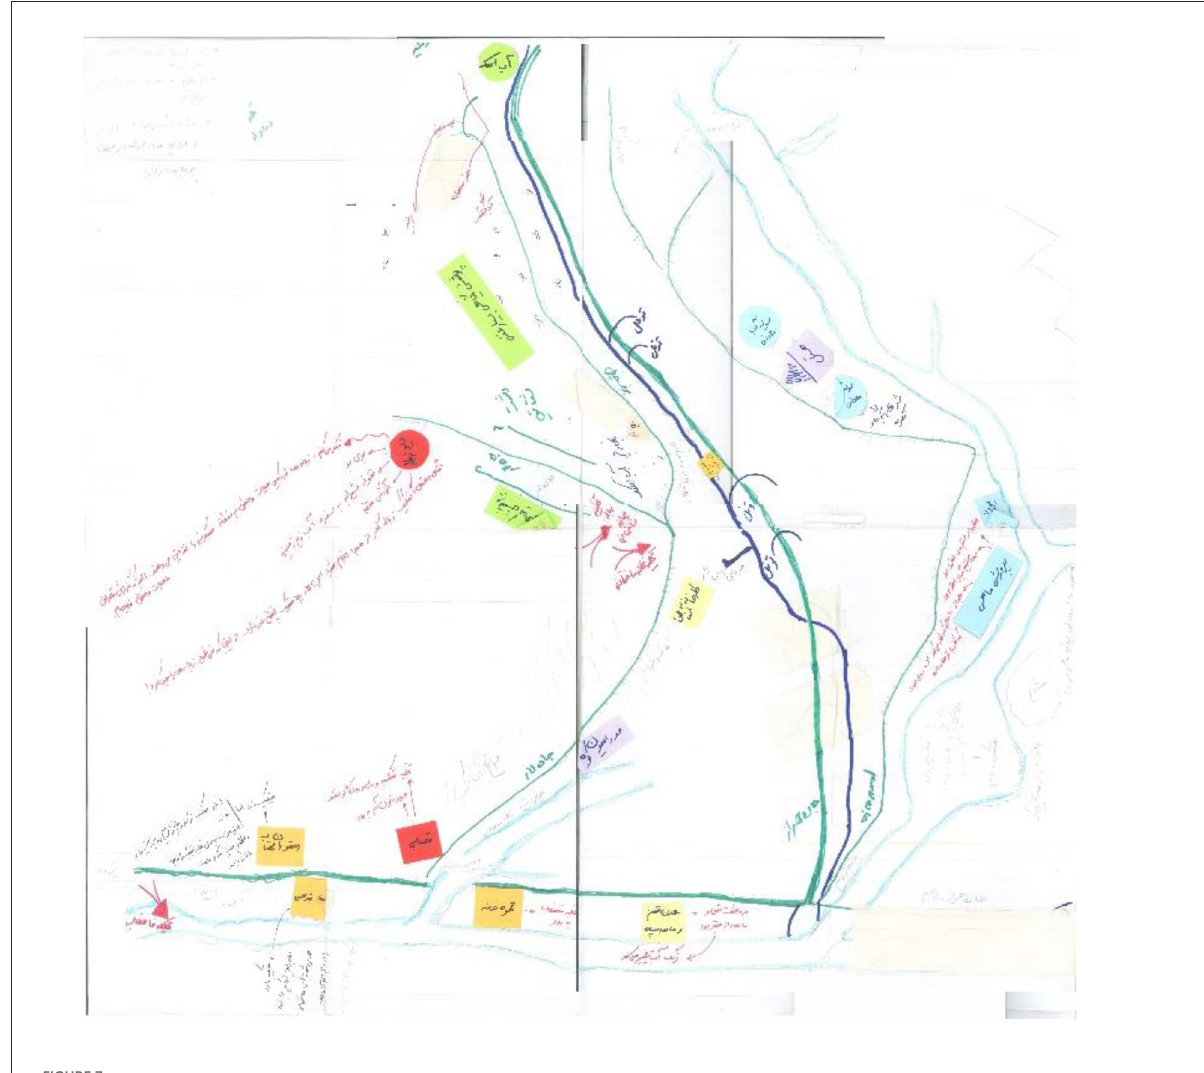
FIGURE7 Transect Map- Ab-e Ask village.